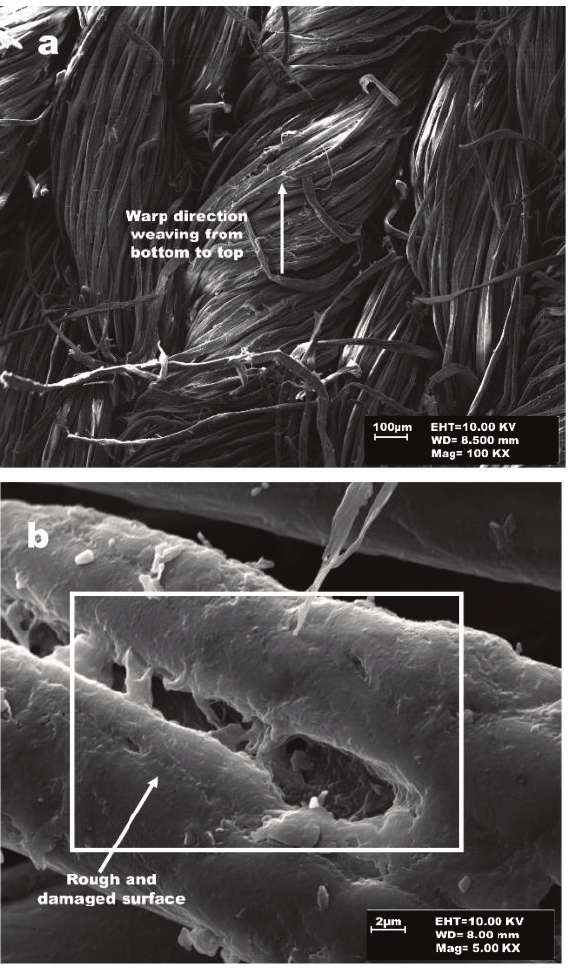
Fig. 4. (a) SEM image of warp direction woven from bottom to top, (b) surface damage at higher magnification.